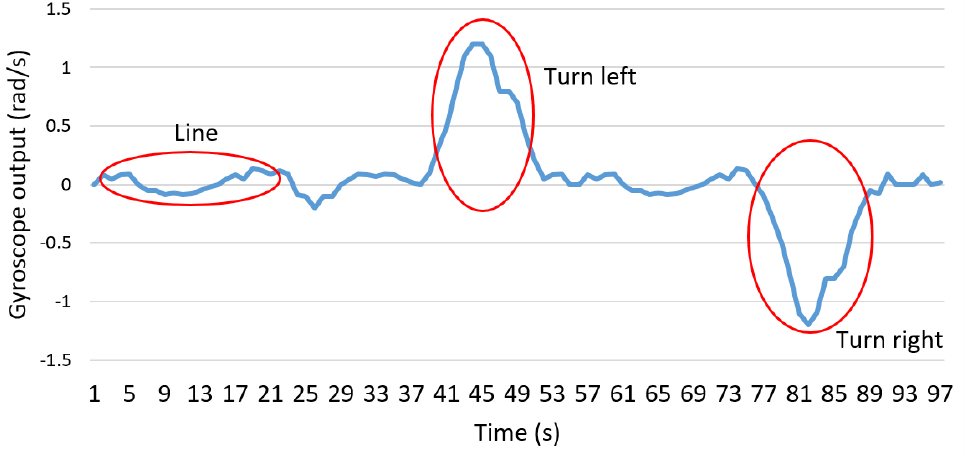
Figure 6. Identification of curves and lines.